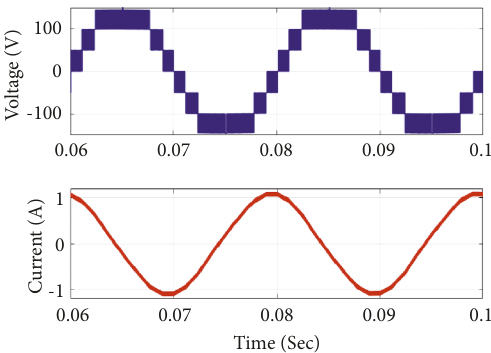
Figure 12: Output voltage and current (MI �